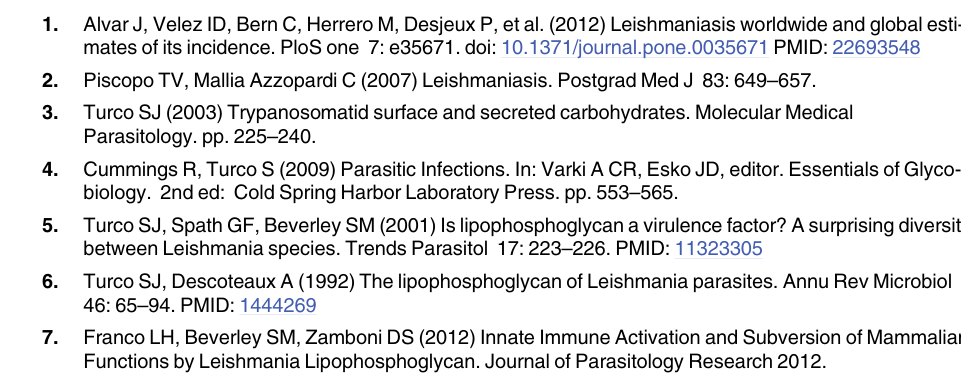
S6 Fig. L . major LV39c5 induced hDC IL12 responses do not differ between LV39c5 mutants. Human DCs (n = 4 donors) were infected with L . major parasites: L . major FV1 WT (FV1), L . major LV39c5 WT (LV39c5), LV39c5 PG null (LV39c5 lpg2 − ), and LV39c5 PG add back (LV39c5 lpg2 − /+LPG2 ). At 8 hrs post infection, IL12B expression was measured by method and depicted as fold change qRT-PCR. Fold change was calculated utilizing the ΔΔ C T over uninfected samples. Box plots display the median value (line), the interquartile range (box), and Tukey whiskers encompassing data within 1.5 fold of the interquartile range. (cid:3) Statistical significance as compared to uninfected control, (p < 0.05). All values were signifi- cantly greater than uninfected. S1 Table. Primers used for molecular generation of L . major FV1 mutants. S2 Table. Human Primer Sequences for qRT-PCR